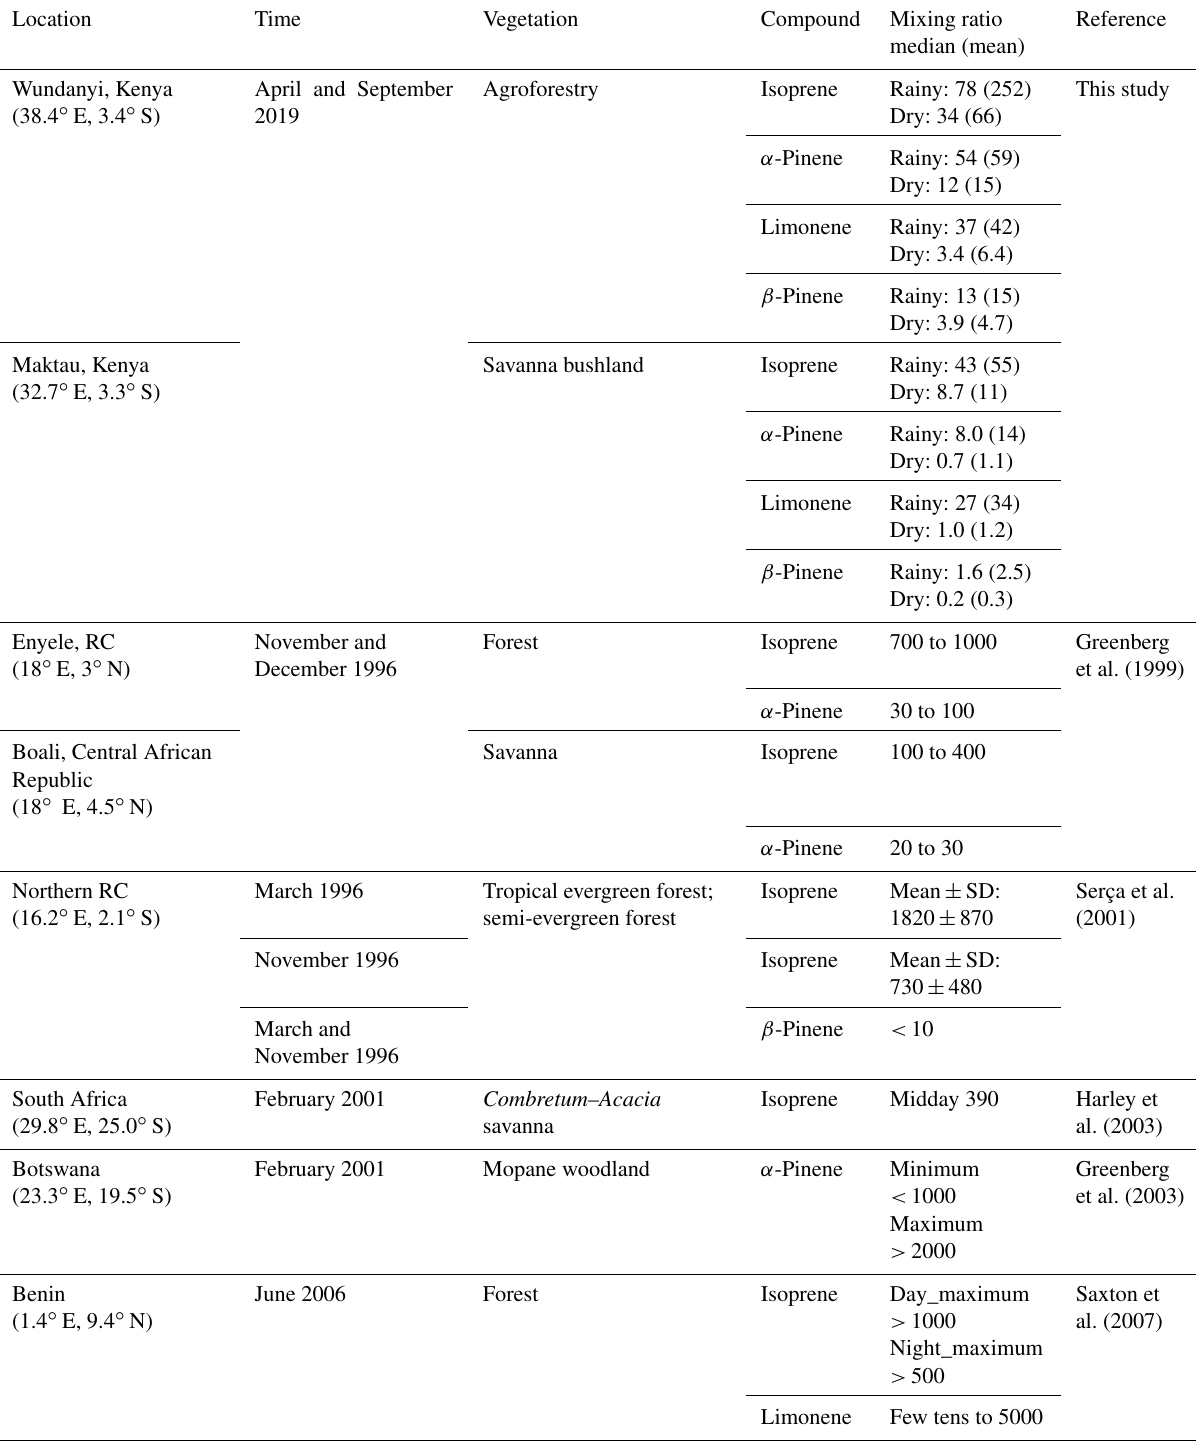
Table 2. Mixing ratios of biogenic volatile organic compounds in different ecosystems in Africa (mixing ratios are presented as median and mean values, except those with extra explanations (e.g., midday, minimum/maximum, and mean ± SD. The unit of mixing ratios is presented in